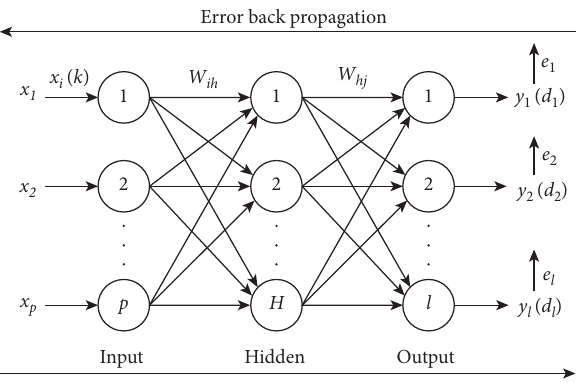
Figure 1: Schematic diagram of three-layer